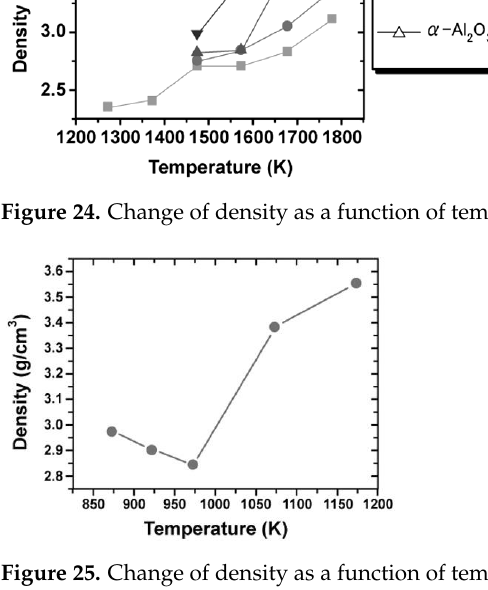
Figure 26. XRD patterns of γ-Al 2 O 3 prepared at 1173–1473 K under 49 MPa. As shown in Figures 25 and 27, it was found that density decreased at 973 K due to phase change to δ and θ - phase. Under the high pressure of 690 MPa, the sintering under- went nearly full densification of γ- alumina at 600 K, a lower temperature [54]. Secondar- ily, when  -alumina powder with a grain size of 100 nm used, a consolidation by SPS method performed at the heating rate of 123 K/min under the pressurizing conditions of 30 MPa or 100 MPa shown in Figure 28. Nano-structured dense alumina with a grain size less than 300 nm, 99.18%TD was synthesized under the conditions of 1423 K and 100 MPa. At the same, 1423 K with 30 MPa, the sintered one reached 86.9% TD. To obtain a 98.3% TD-dense alumina compact with 30 MPa, a higher temperature of 1473 K was required. In Figure 28, fractured surfaces of FE-SEM, it is indicated that the difference in the applied pressure at the consolidation temperature of 1423 K drastically changes the microstructure in the SPS-consolidated  -Al 2 O 3 . That is, full densification and nano-structure can be at- tained by SPS consolidation when the preferable pressurizing condition is selected with- out selecting such a high heating rate. The heating rate is more important for the synthesis of a dense nano-structure and highly transparent alumina, though applied pressure is also correlated with the generation of the structural tailoring. The findings suggest that it is important to select an optimum combination between SPS parameters and heating rate that is delicately effective for generating new micro/nano-structures in the SPS-consoli- dated ceramics [55]. High-temperature short-period SPS sintering is expected to provide almost all ceramic materials with new characteristics and sintered effects that are different from those obtained by the HP and HIP processes. On Al 2 O 3 , Nygren, et al. investigated and reported detailed SPS effects including grain growth and SPS sintering conditions [24].